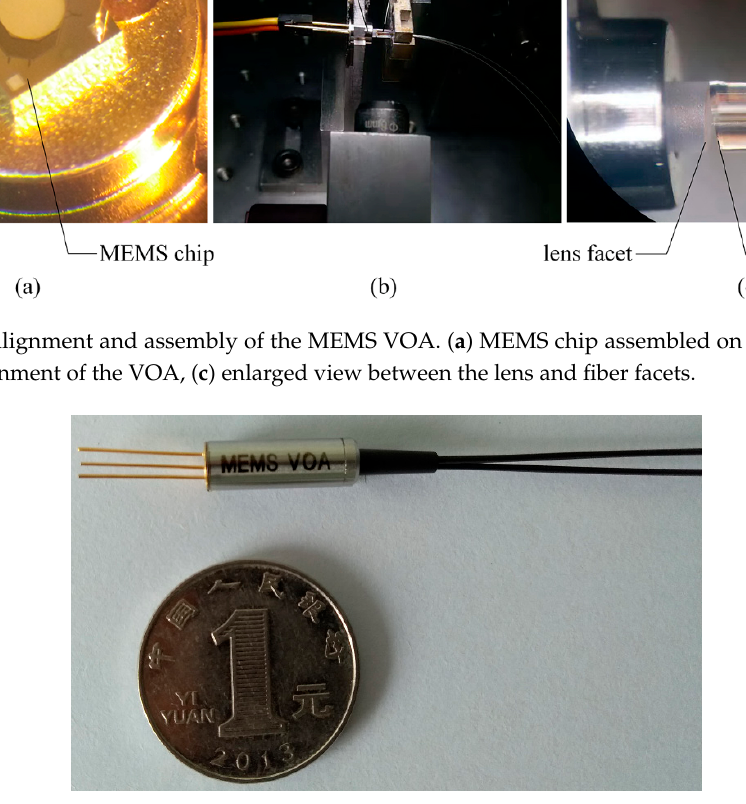
Figure 7. Photograph of the VOA sample.